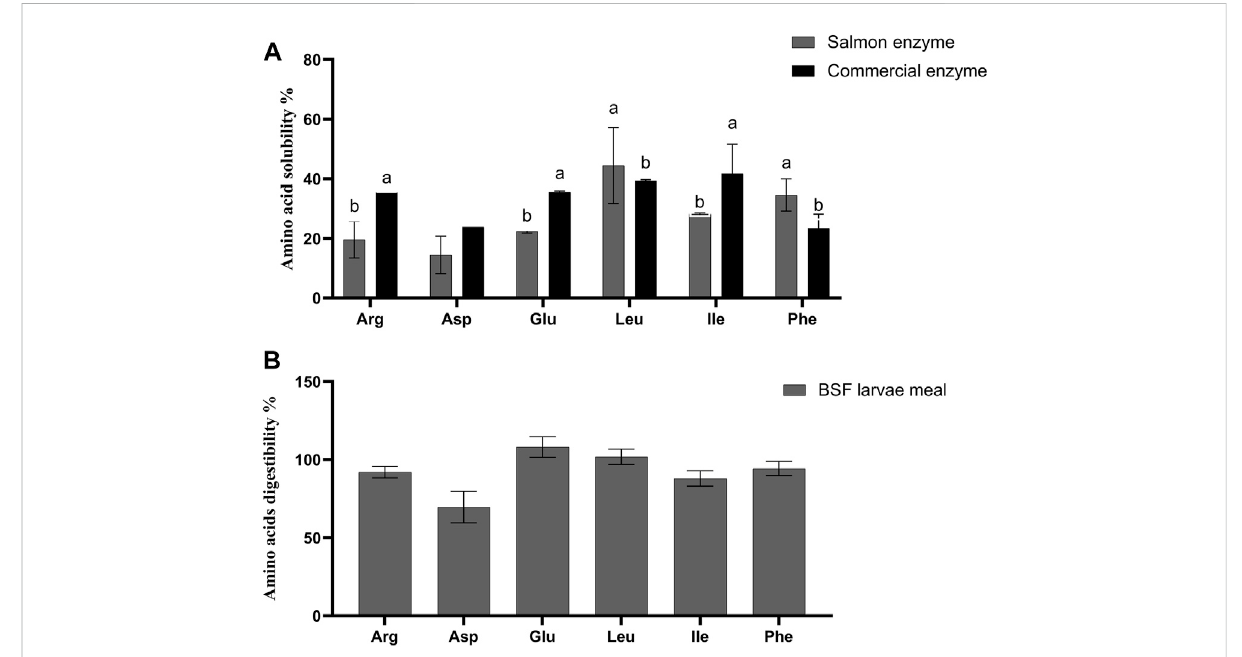
FIGURE 2 (A) In vitro aminoacids solubility ofblacksoldier fl ylarvaemeal (BSF). Values aremeansof3values,withtheirstandard deviationrepresented by vertical bars. Small letters (A,B) indicate the statistical difference between salmon enzyme, and commercial enzyme detected with one-way ANOVA followed by Tukey ’ s multiple comparisons. In vitro solubility values of black soldier fl y larvae meal (BSF) for remaining amino acids are presented in SupplementaryTableS2 (B) Invivo aminoacidsdigestibilityofblacksoldier fl ylarvaemeal(BSF).Valuesaremeansof3values,withtheirstandard deviation represented by vertical bars. In vivo digestibility values of the black soldier fl y larvae meal (BSF) for remaining amino acids are presented